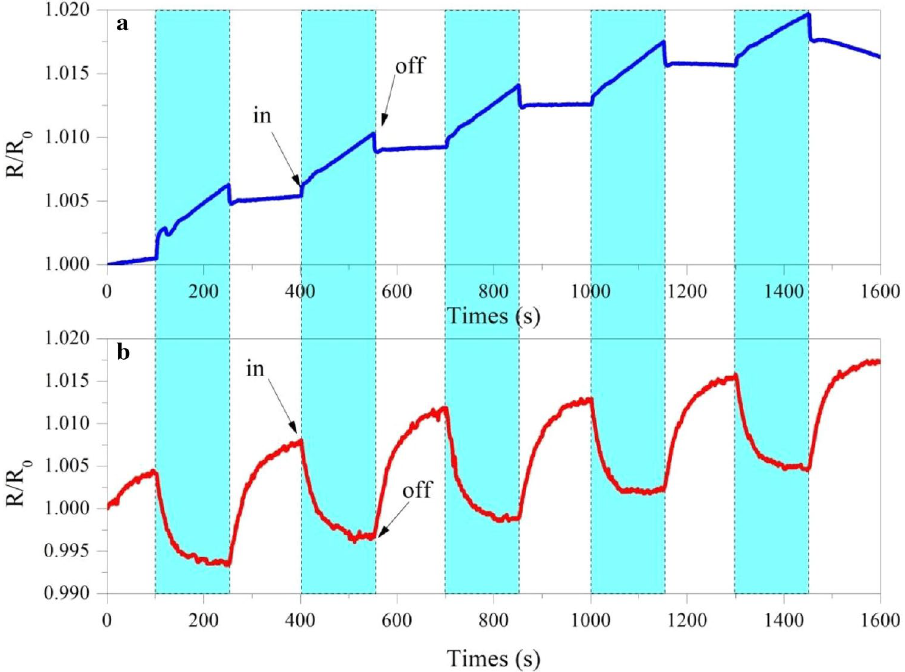
Figure 7. The relative resistance in presence and absence of 1000 ppb NO gas ( a ) N-rGO and ( b ) rGO.